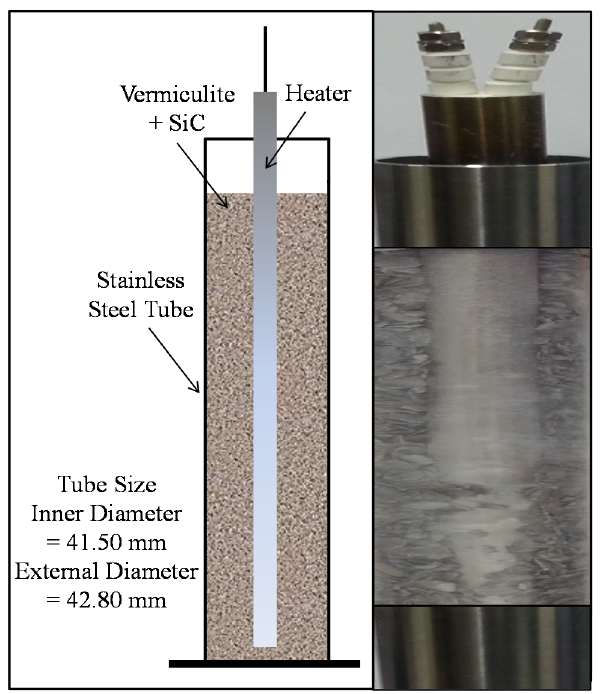
Figure 2. Stainless steel tube filled with vermiculite, silicon carbide (SiC), and cartridge heater.